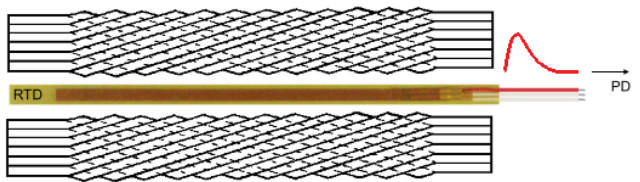
Figure 24. RTD allocated in the slot, adapted from [98].